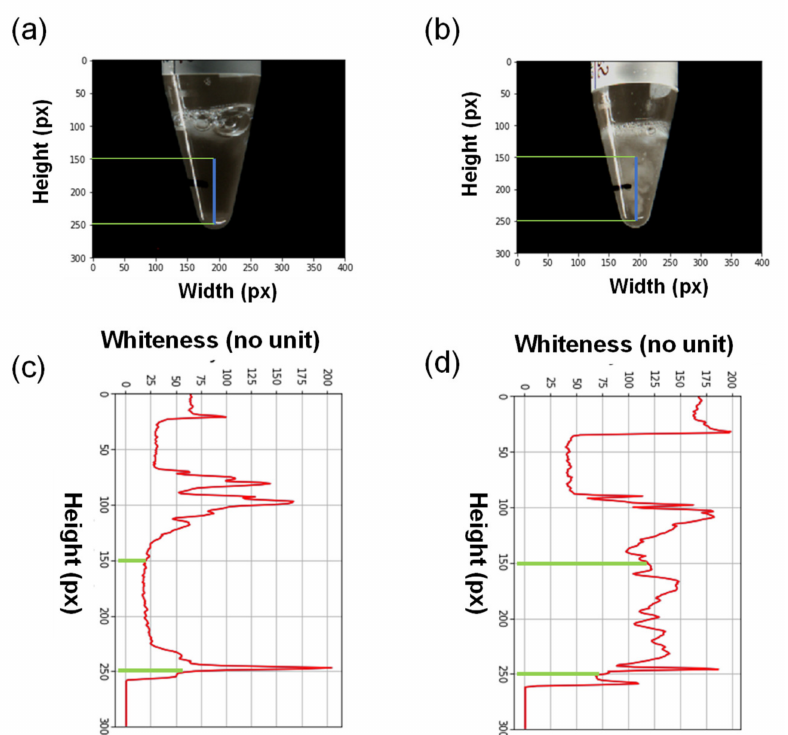
Figure A1. Representative images of acceptable ( a ) and unacceptable ( b ) saliva. The intensity of the whiteness was calculated between the green lines ( c , d ). The area between the green lines under the red curves was integrated, and ≥ 40% of the integrated area between the green lines was considered to represent high whiteness